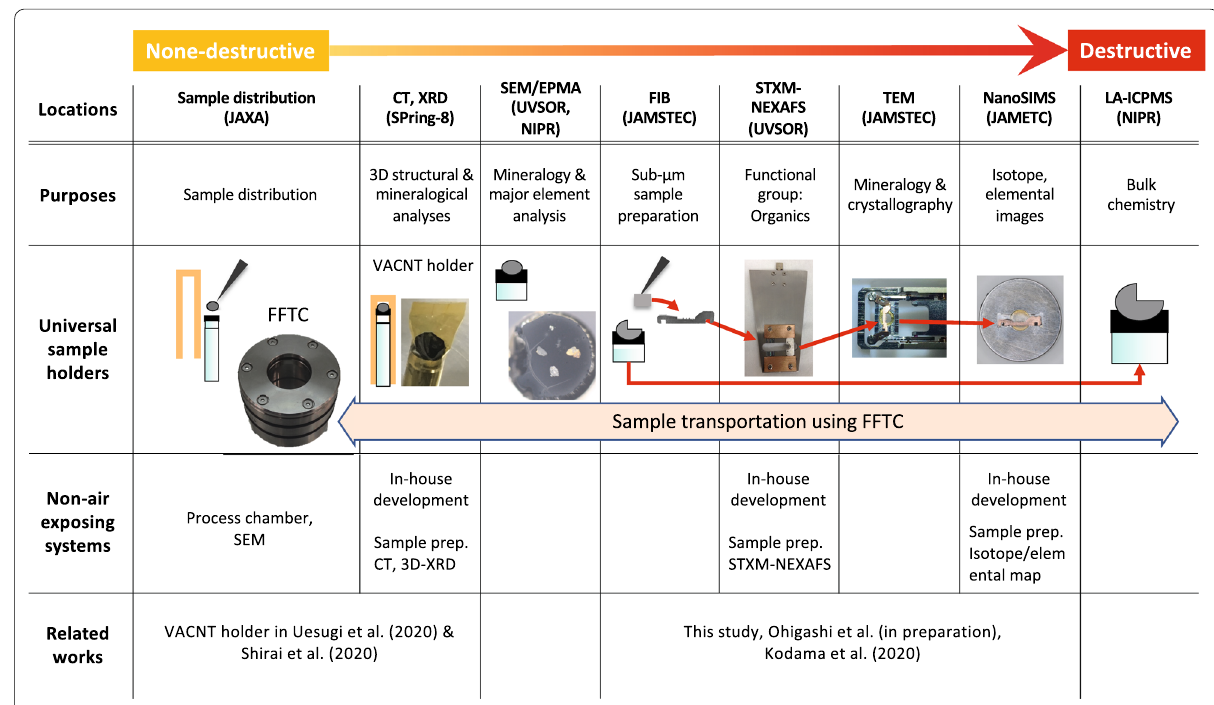
Fig. 7 Coordinated analysis of the Ryugu